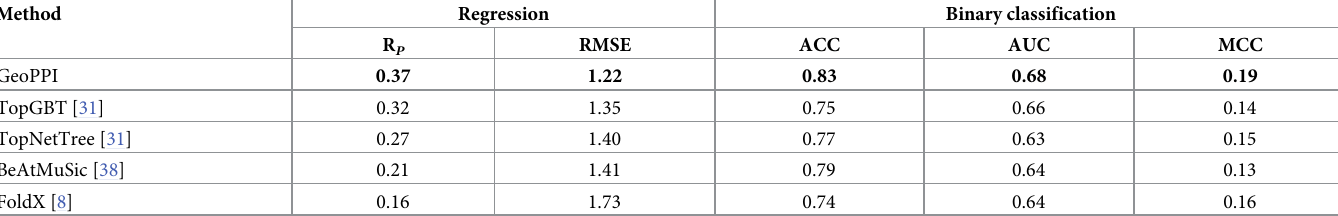
Table 3. Comparison of prediction performance of GeoPPI with that of different baseline methods on the S641 dataset. In this test, the S1131 dataset is the training dataset of GeoPPI, TopGBT and TopNetTree. Besides the regression performance, a binary classification experiment is conducted to evaluate the ability of classifying the stabilizing and destabilizing mutations in terms of the classification accuracy (ACC), the area under the receiver operating characteristic curve (AUC) and Matthews corre- lation coefficient